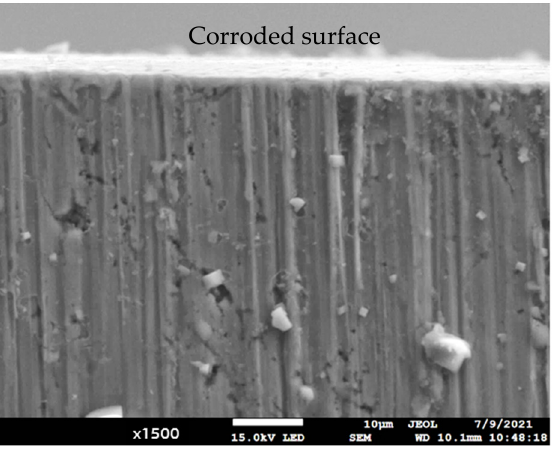
Figure 12. The corroded HF62 sample; including the oxide layer on the surface, trapped fine particles in the substrate and corrosion cracks.